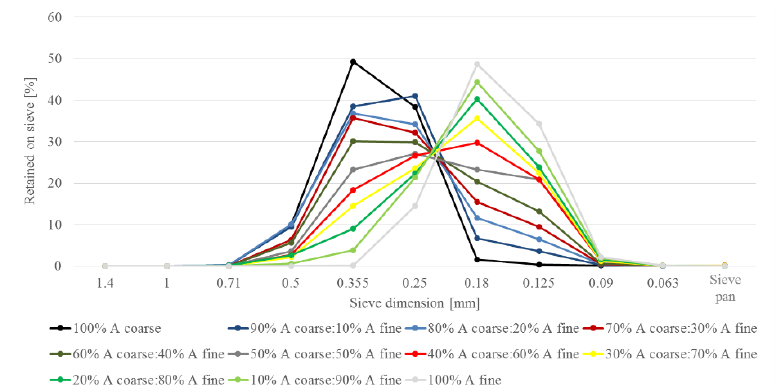
Figure 7. Grain size distribution curves for sands A coarse and A fine. Table 2. Basic properties of sands A coarse and A fine.